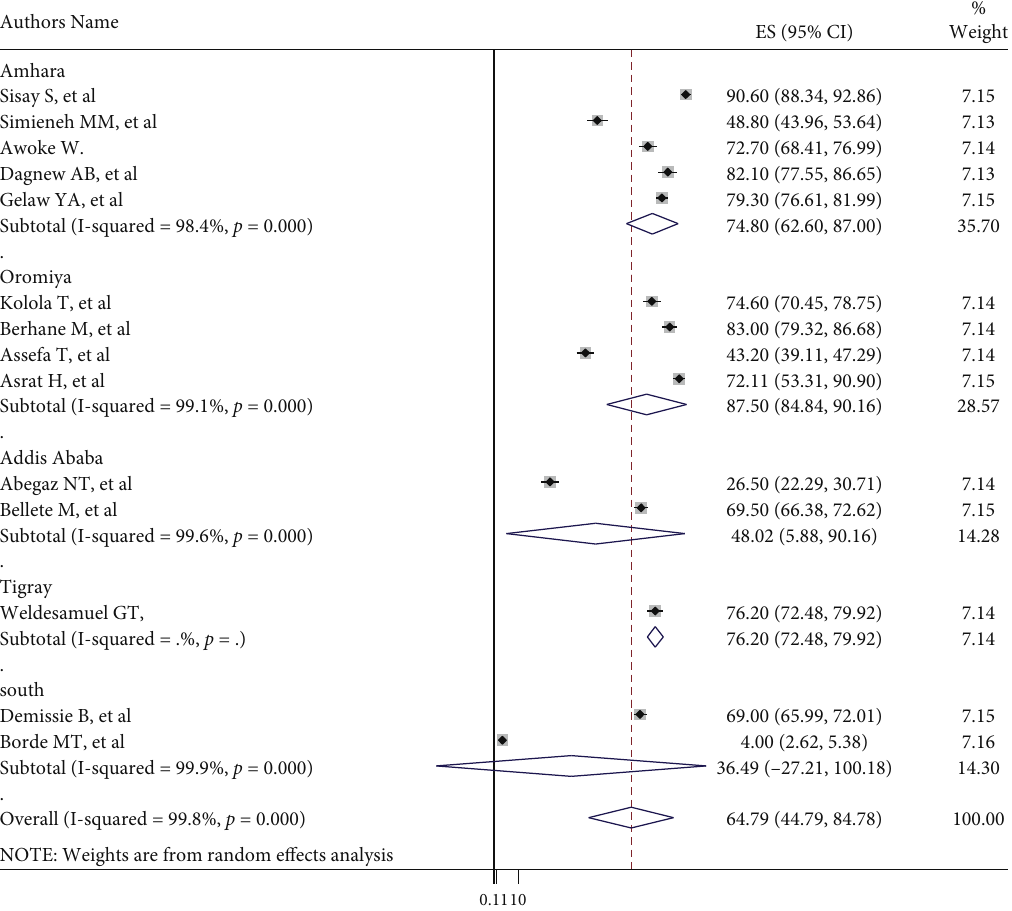
Figure 3: Subgroup analysis of mother ’ s care-seeking behavior for common childhood illnesses in Ethiopia by